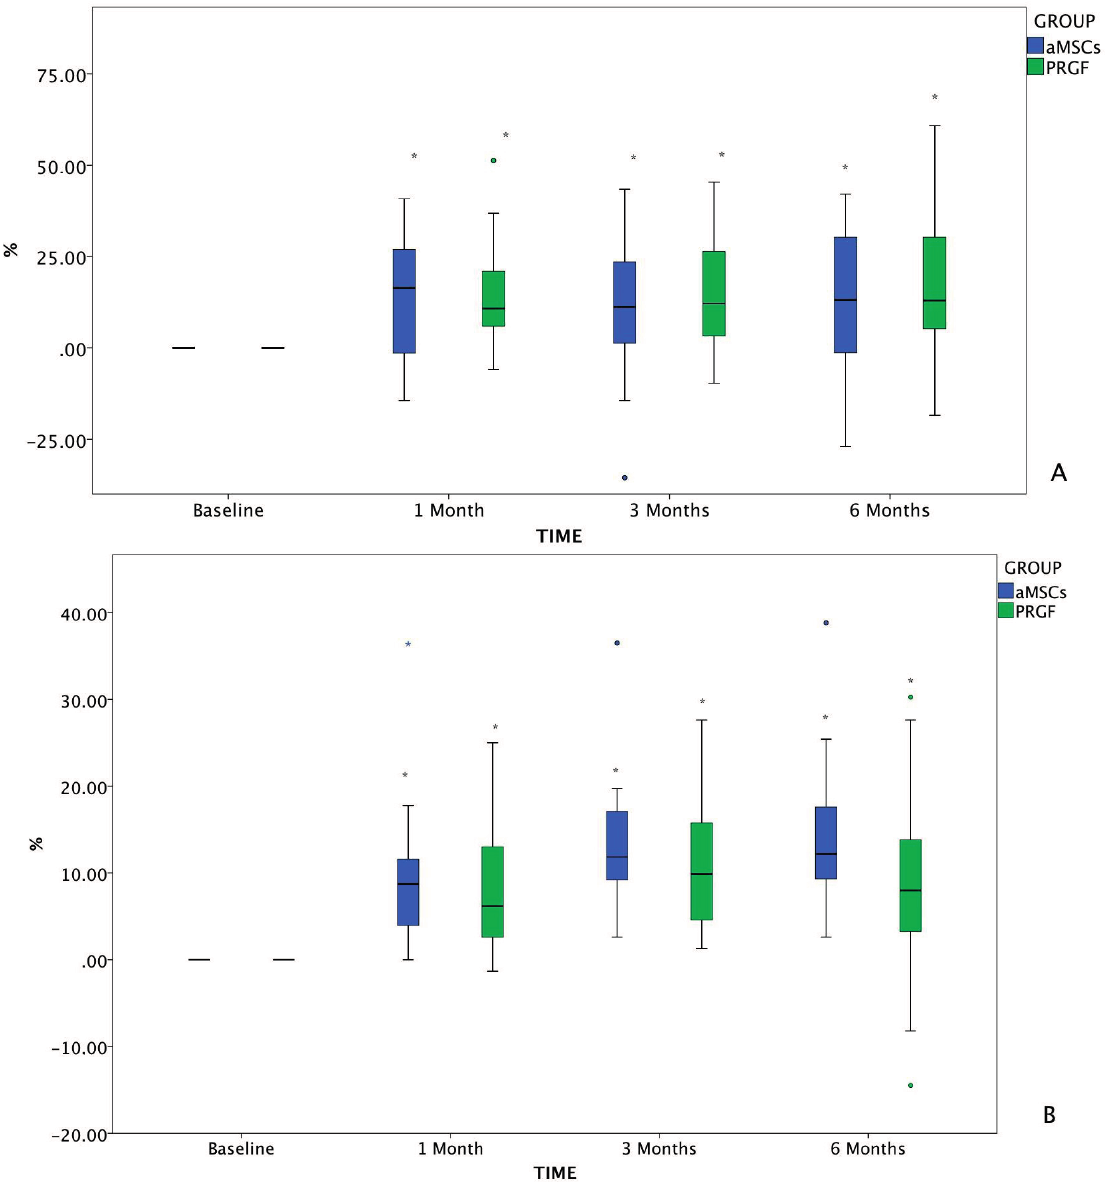
Figure 2. Changes in VAS from baseline value assessed by the owner ( A ) and the investigator ( B ). The changes in VAS which differed significantly with baseline ( p < 0.05) are marked as * . The circles, both green and blue, correspond to anomaly/outlier data included in the statistical study. The blue asterisk corresponds to an outlier, to which the Dixon Q test was applied in order to confirm deletion of the value from the